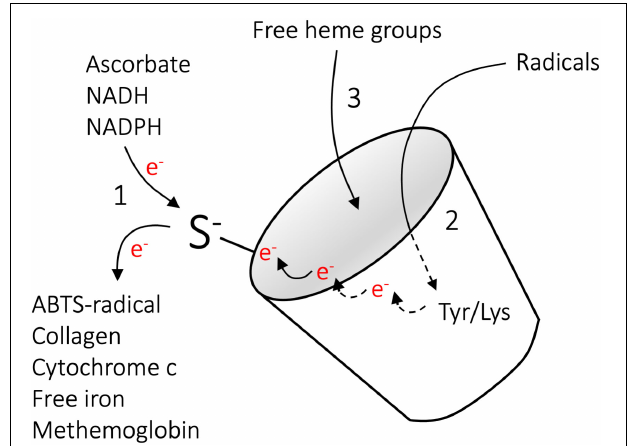
FIGURE 4 | Molecular mechanisms of A1M. The molecular mechanisms implicated in the actions of A1M include (1) reductase activity (2) radical scavenging and (3) heme binding. The reductase activity is driven by the free thiol group of C34, is catalytic in the presence of the electron-donating co-factors NADH, NADPH, or ascorbate, and several substrates have been identified (Allhorn et al., 2005). The radical-scavenging reaction is also driven by C34, which, in the absence of electron-donating co-factors, can oxidize Y32 and Y132 to tyrosyl-radicals via intramolecular electron-transfer. This is followed by reactions with external radicals, ultimately leading to covalent trapping of the radicals and modification of the side-groups (Åkerström et al., 2007). In vivo , covalent modifications have been shown on the side groups of K69, K92, K118, and K130, suggesting a similar radical trapping mechanism on lysine residues. Binding of heme-groups were shown on two separate binding sites (Allhorn et al., 2002; Siebel et al., 2012; Rutardottir et al., 2016). Reproduced from Gunnarsson et al.